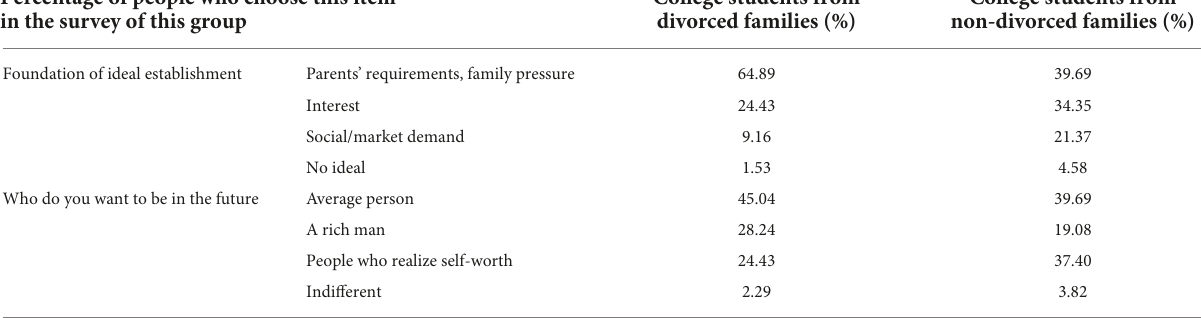
TABLE 2 Partial survey data on employment